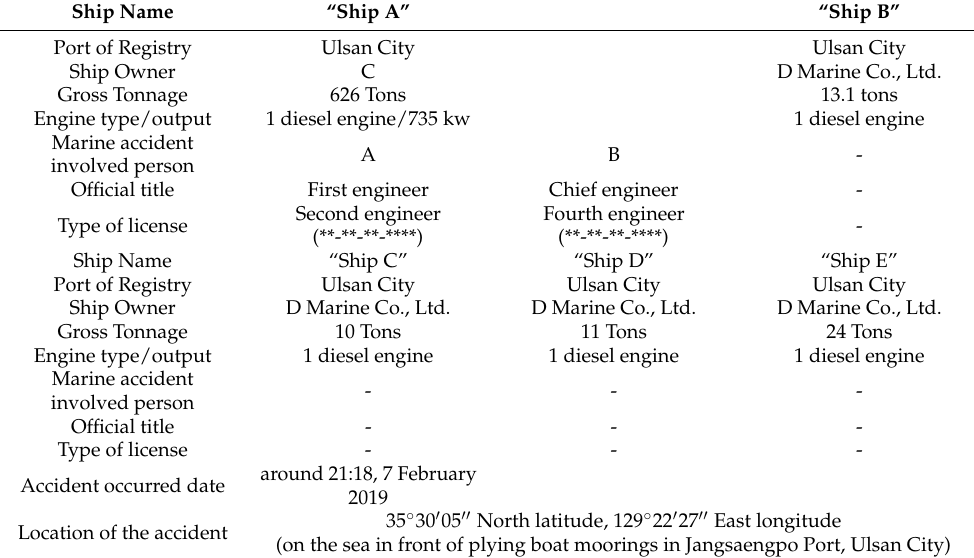
Table A1. Information of ships involved in the